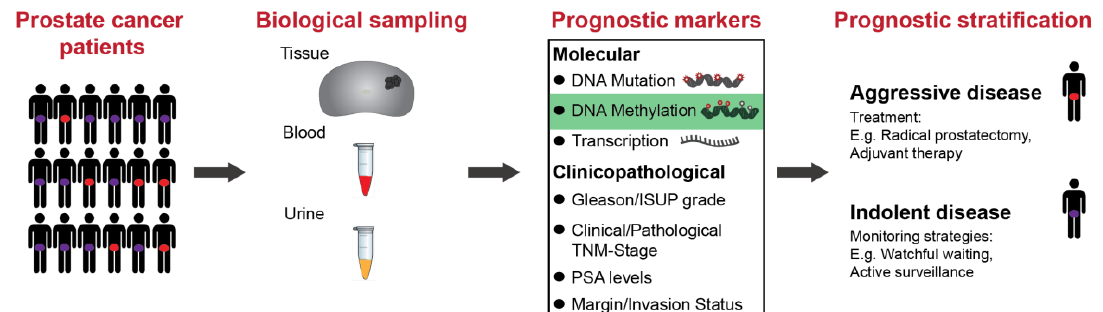
Figure 1. Schematic showing the pathway for the application of biomarkers for improved prognostic stratification in prostate cancer patients. Prostate cancer is a heterogeneous disease and identifying those patients at diagnosis that have aggressive vs indolent disease is critical in informing the clinical management of these patients. Biological sampling includes tissue biopsies, and blood and urine samples. These are assayed using molecular biomarkers, including DNA mutations,